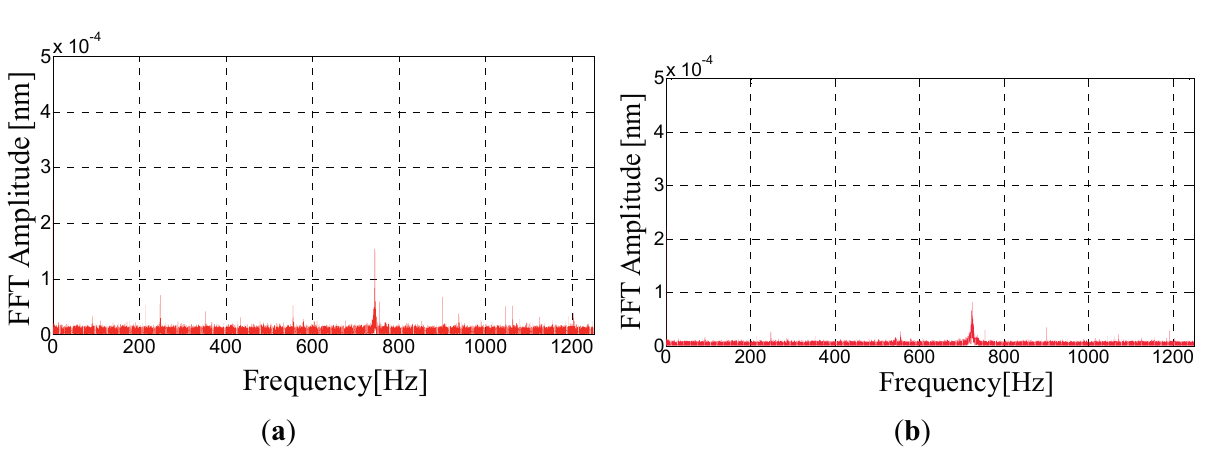
Figure 14. ( a ) FFT Amplitude of FBG accelerometers labeled K1; ( b ) FFT Amplitude of FBG accelerometers labeled K1.